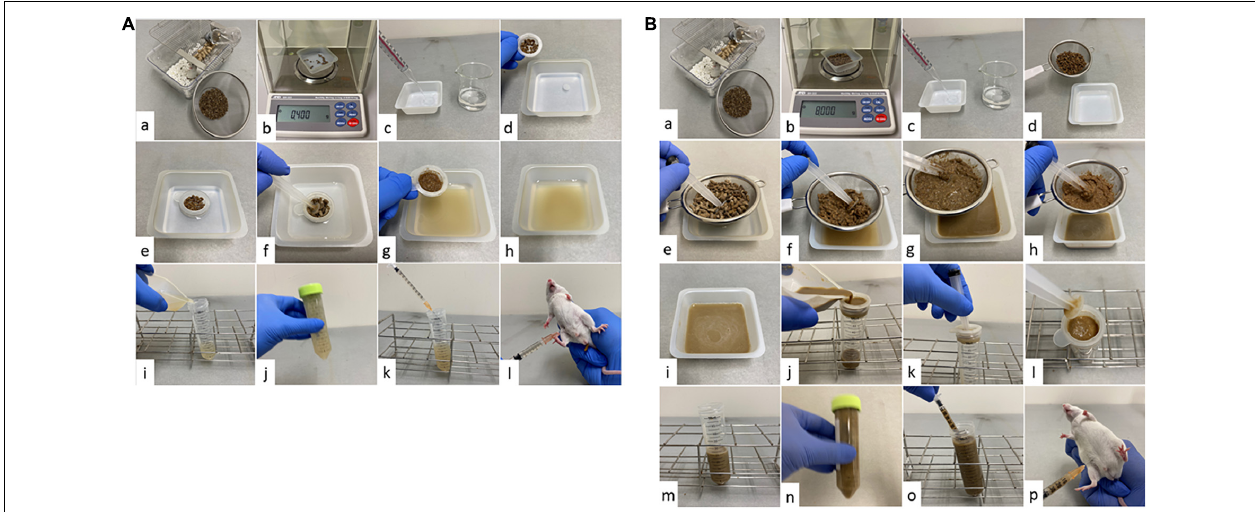
FIGURE 1 | Procedure for creating the fecal suspension intraperitoneal injection (FSI) model. (A) FSI model with thin fecal suspension. (a) Collect the required amount of feces from the cage. Spread enough paper matting to prevent urine from mixing with feces. Eliminate as much non-fecal waste as possible and be careful